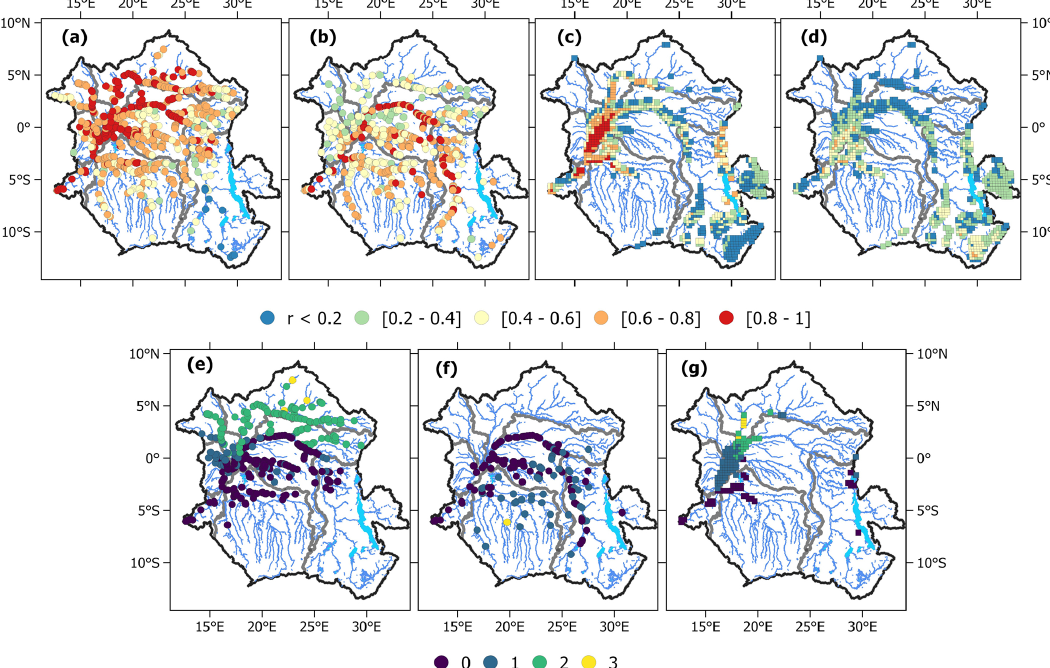
Figure 12. Similar to Fig. 11 but considering the two distinct periods of the year corresponding to each hydrological peak observed at Brazzaville/Kinshasa. (a) The optimum coefficient correlation between altimetry-derived SWH (from ERS2, ENV, SRL, J2/3, and S3A missions) at each VS against the in situ water stage at the Brazzaville/Kinshasa station for the period of August–February. (b) Same as panel (a) but for the period of March–July. (c) The optimum coefficient correlation between SWE at each GIEMS-2 against in situ discharge at the Brazzaville/Kinshasa station for the period of August–February. (d) Same as panel (c) but for the period of March–July. (e–g) The time lag (in months) associated, respectively, to panels (a–c) but only for cases where the maximum correlation has p value < 0.05. The time lag associated to panel (d) has too few values with a p value < 0.05 and is therefore not